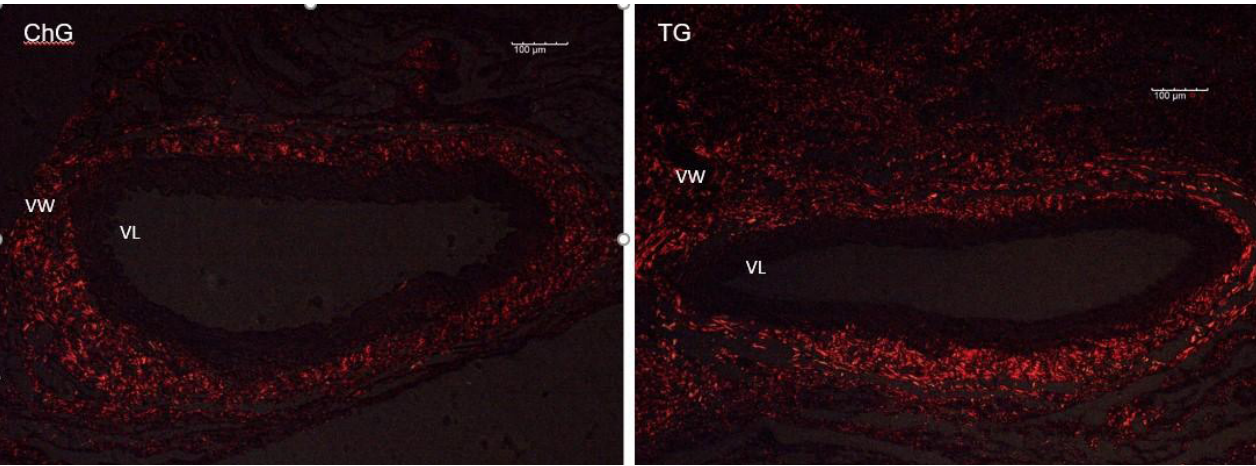
Fig. 4 - Photomicrograph of surgical specimens collected from the experimental chitosan group (ChG) and TachoSil® group (TG) on the 21 st postoperative days. Specimens stained with Picrosirius Red. Note the presence of collagen fibres adjacent to the vessel walls (VW) and surrounding the lumen of the vessel (VL). The intensity and birefringence of red characterize the presence of type I fibres. Type III collagen fibres were not significantly